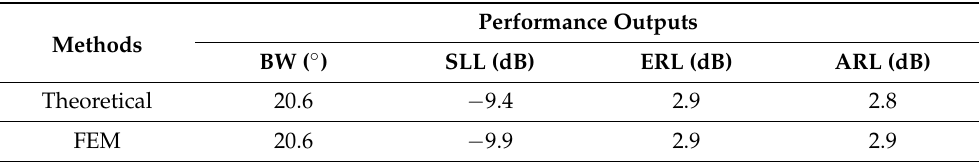
Figure 13. Comparison of the theoretical and finite element analysis beam patterns of the SA: ( a ) elevation plane; ( b ) azimuth plane. Table 7. Quantitative values of the performance outputs from the theoretical and finite element analysis beam patterns of the SA.